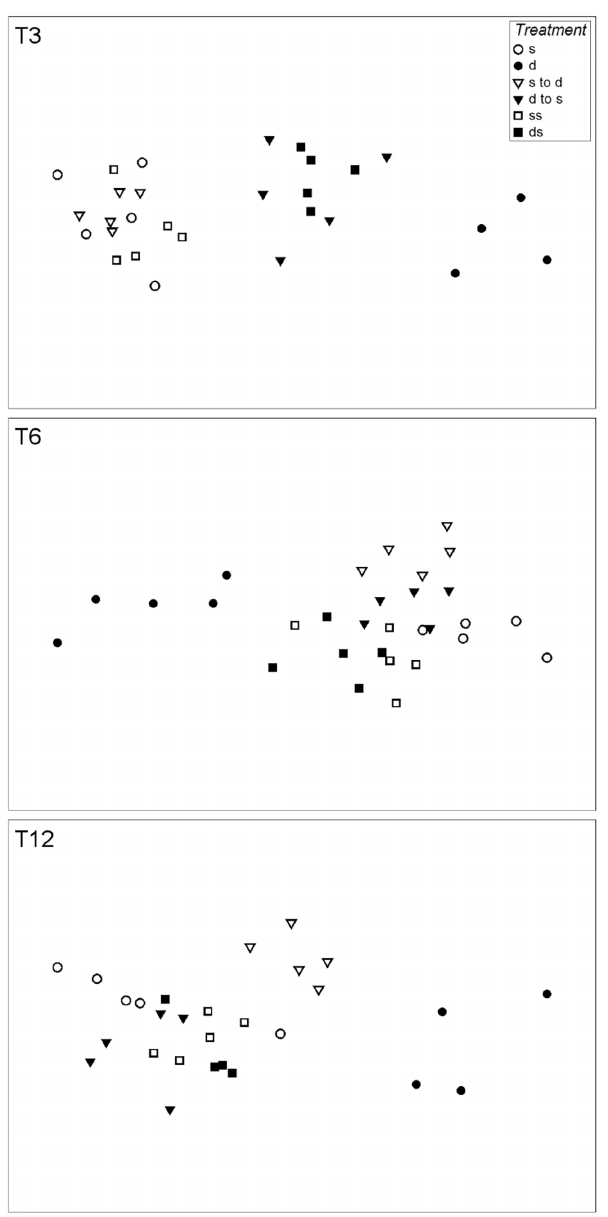
Fig 3. Non-metric multidimensional scaling (nMDS) plot of nematode species composition. Data is shown for samples retrieved after 3, 6, and 12 weeks (T3, T6, and T12, respectively). The nMDS calculations were based on the Bray- Curtis similarity with square root- transformed nematode density data (ind. cm − 2 ) as determined in the epilithon of Lake Erken. Stress values: T3 = 0.07; T6 = 0.11; T12 =